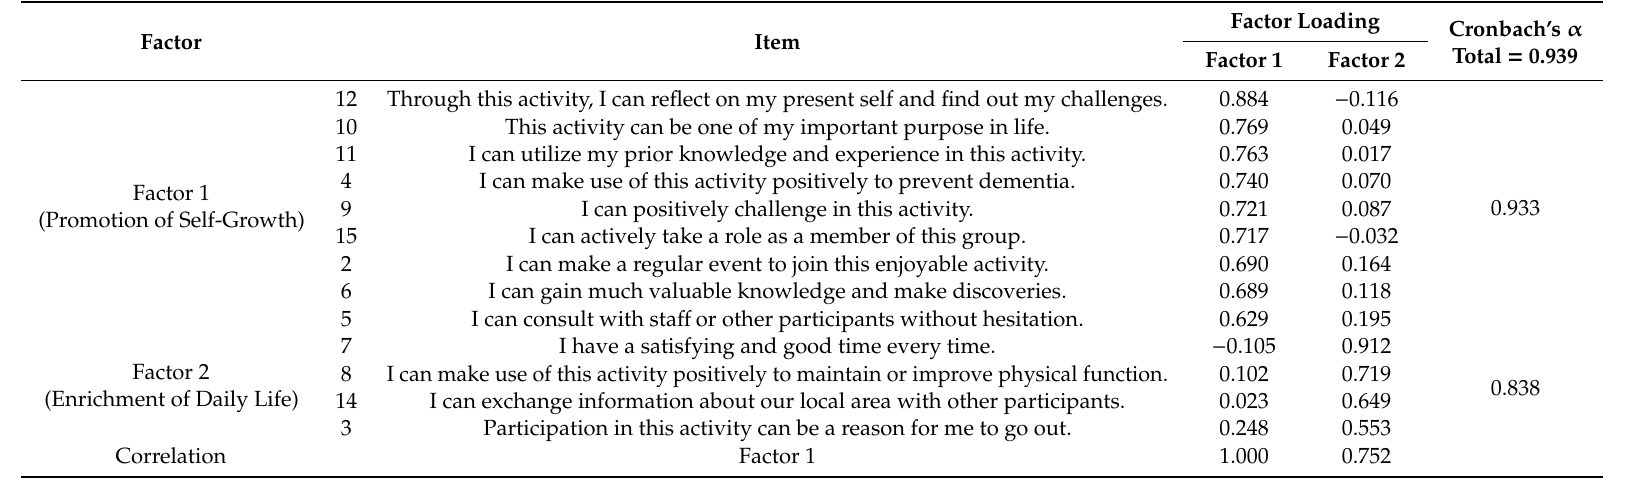
Table 3. Factor structure of the meaning of participation in care prevention group activities ( n =